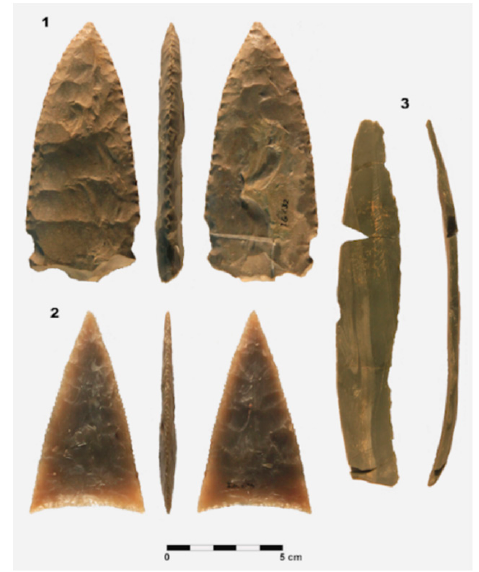
Figure 2. Some of the lithic tools from the tholos of La Zarcita: (1) Z-132, (2) Z-134, and (3) Z-215. Reflectance spectra were collected using an Analytical Spectrometer Device (ASD) Portable Spectroradiometer FieldSpec4STD (Malvern Panalytical, Malvern, UK), which records the amplitude value of electromagnetic waves between 350 nm and 2500 nm (spectral range). This spectroradiometer is designed with three channels, and in each channel, it can distinguish a very small difference in wavelengths (spectral resolution), with a spectral resolution between 3 nm at 700 nm and 10 nm at 1400 and 2100 nm,